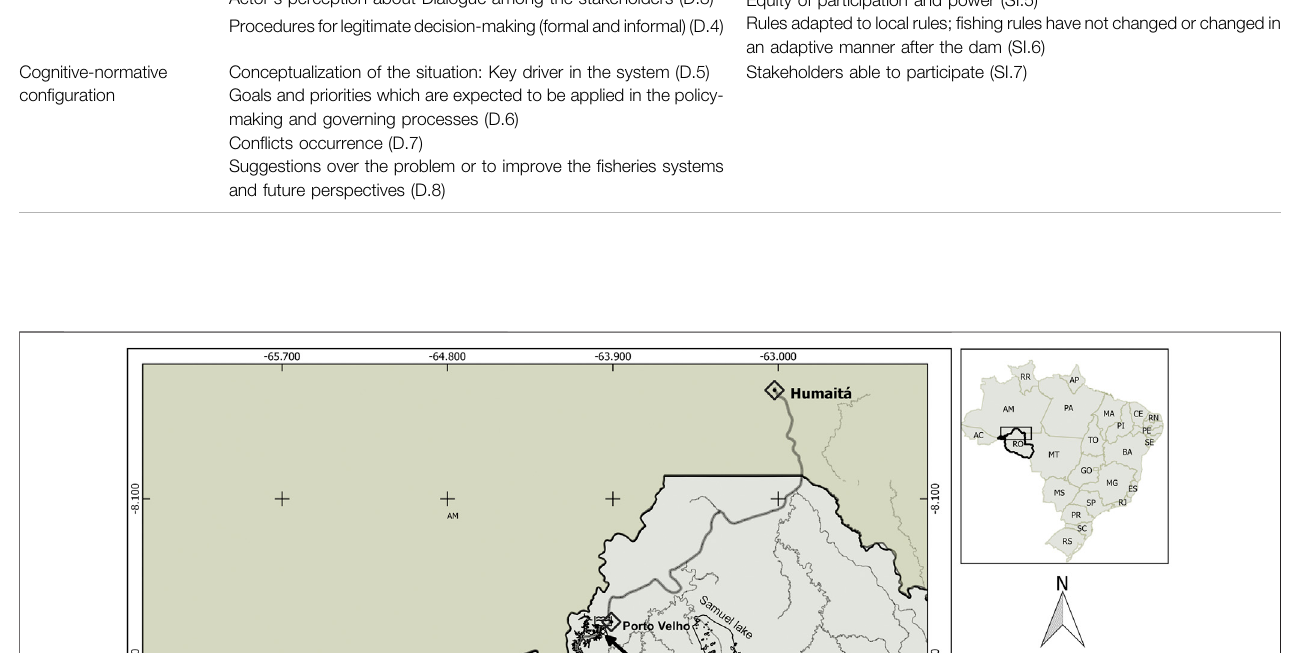
Frontiers in Environmental Science |